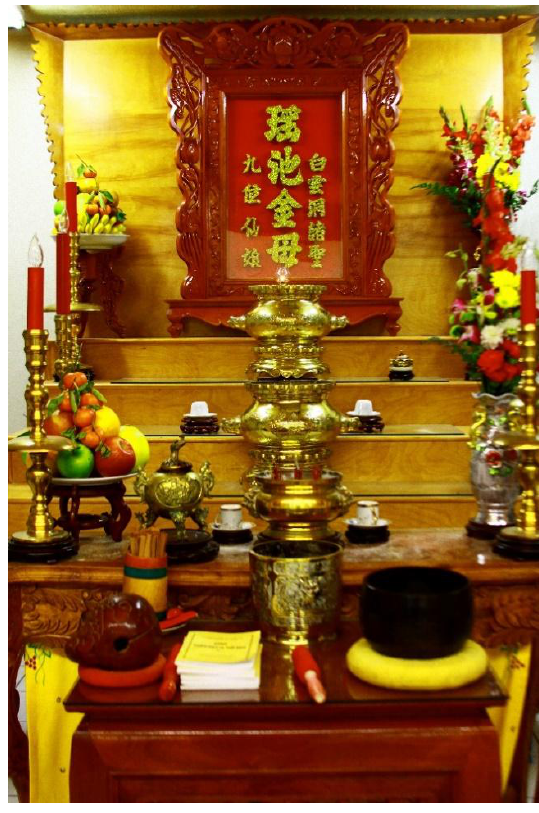
Figure 4. The Mother Goddess altar at the Caodai Chestnut Temple (Westminster, California).